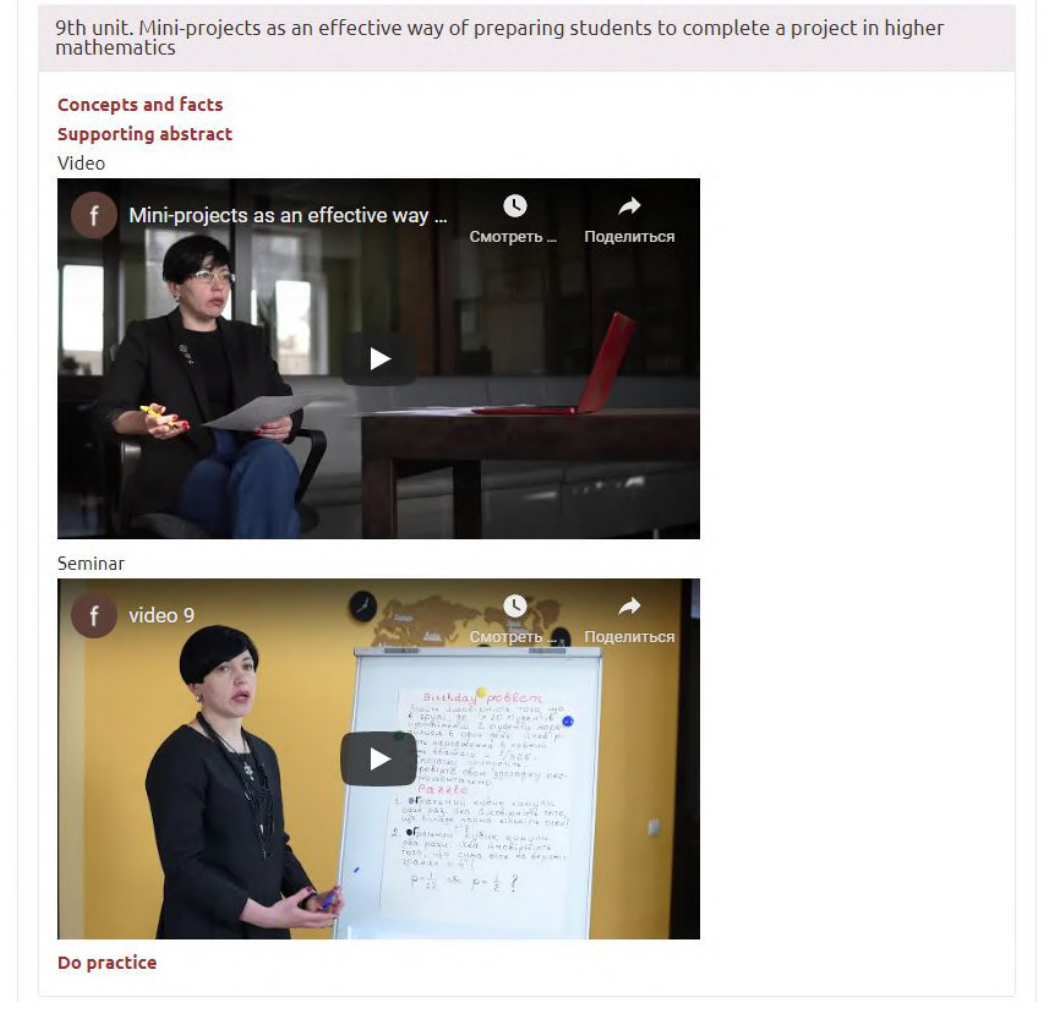
Figure 22: Presentation of paper